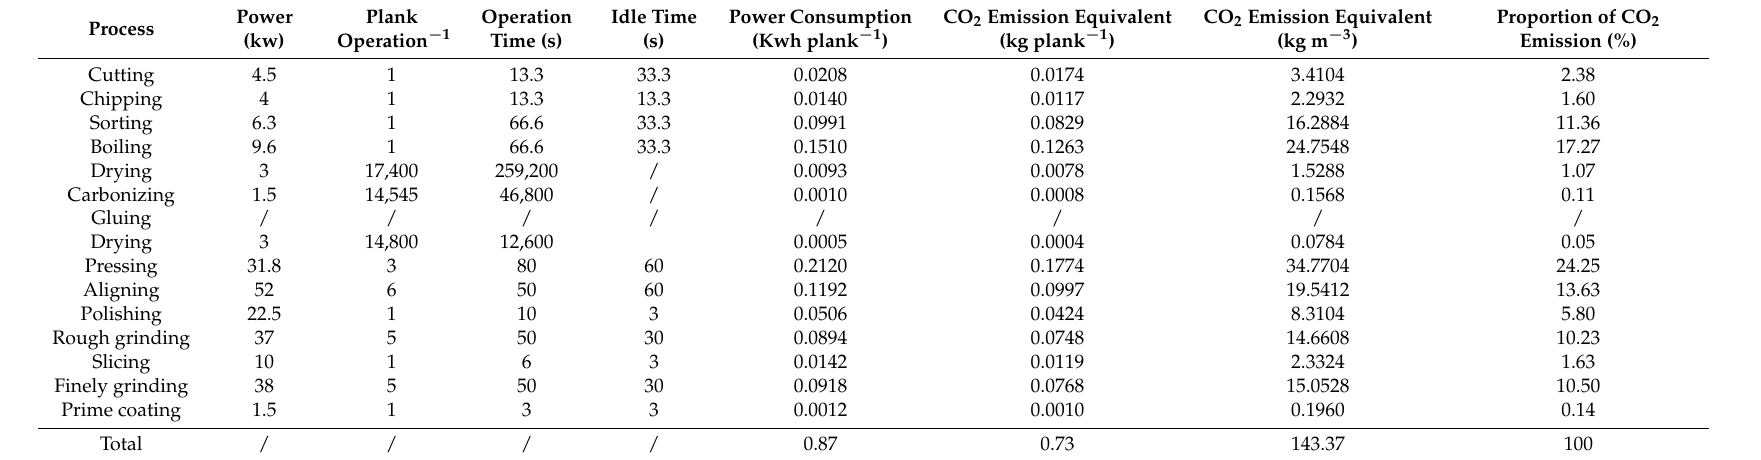
Table 2. Carbon emissions from the production of 1 m 3 bamboo scrimber